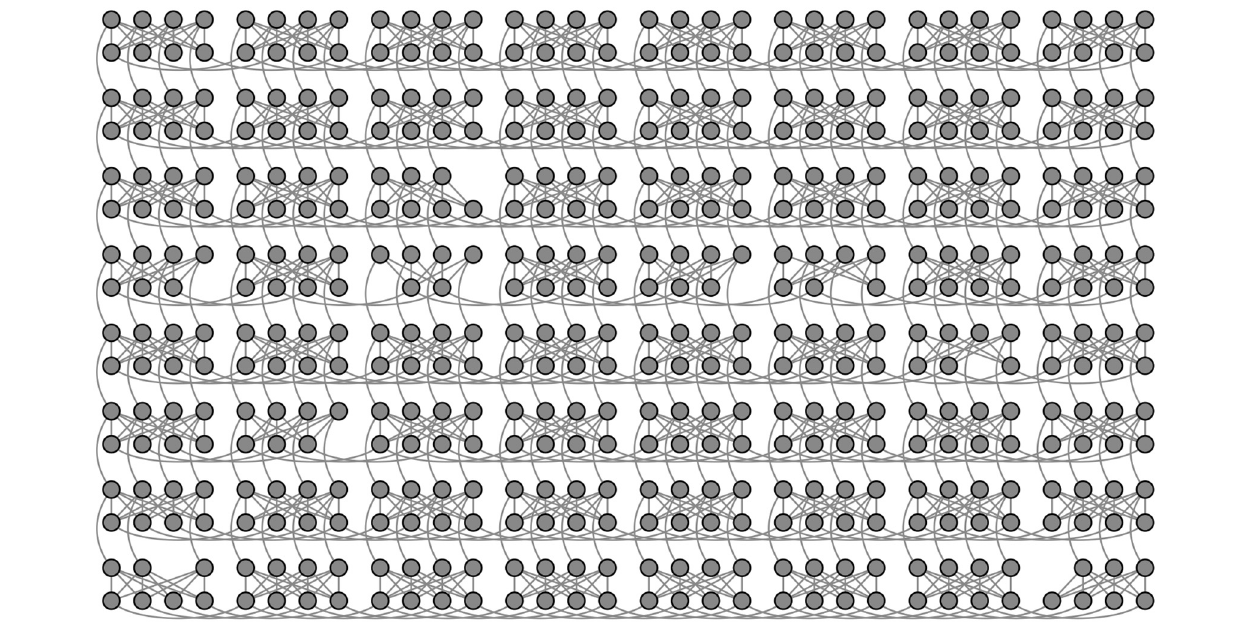
FIGURE 1 | D-Wave’s recent generation Chimera connectivity graph G . Vertices indicate spin-valued variables represented by programmable qubits ( h i ’s), and edges indicate programmable couplers ( J i , j ’s). G is a lattice of K 4 , 4 unit cells where missing qubits are the result of fabrication defects.